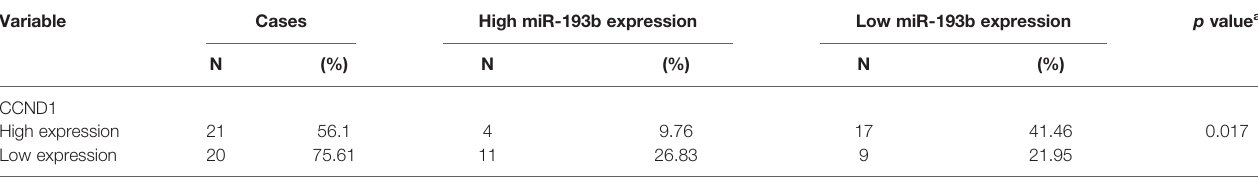
TABLE 2 | Relation between miR-193b, and CCND1 in cervical